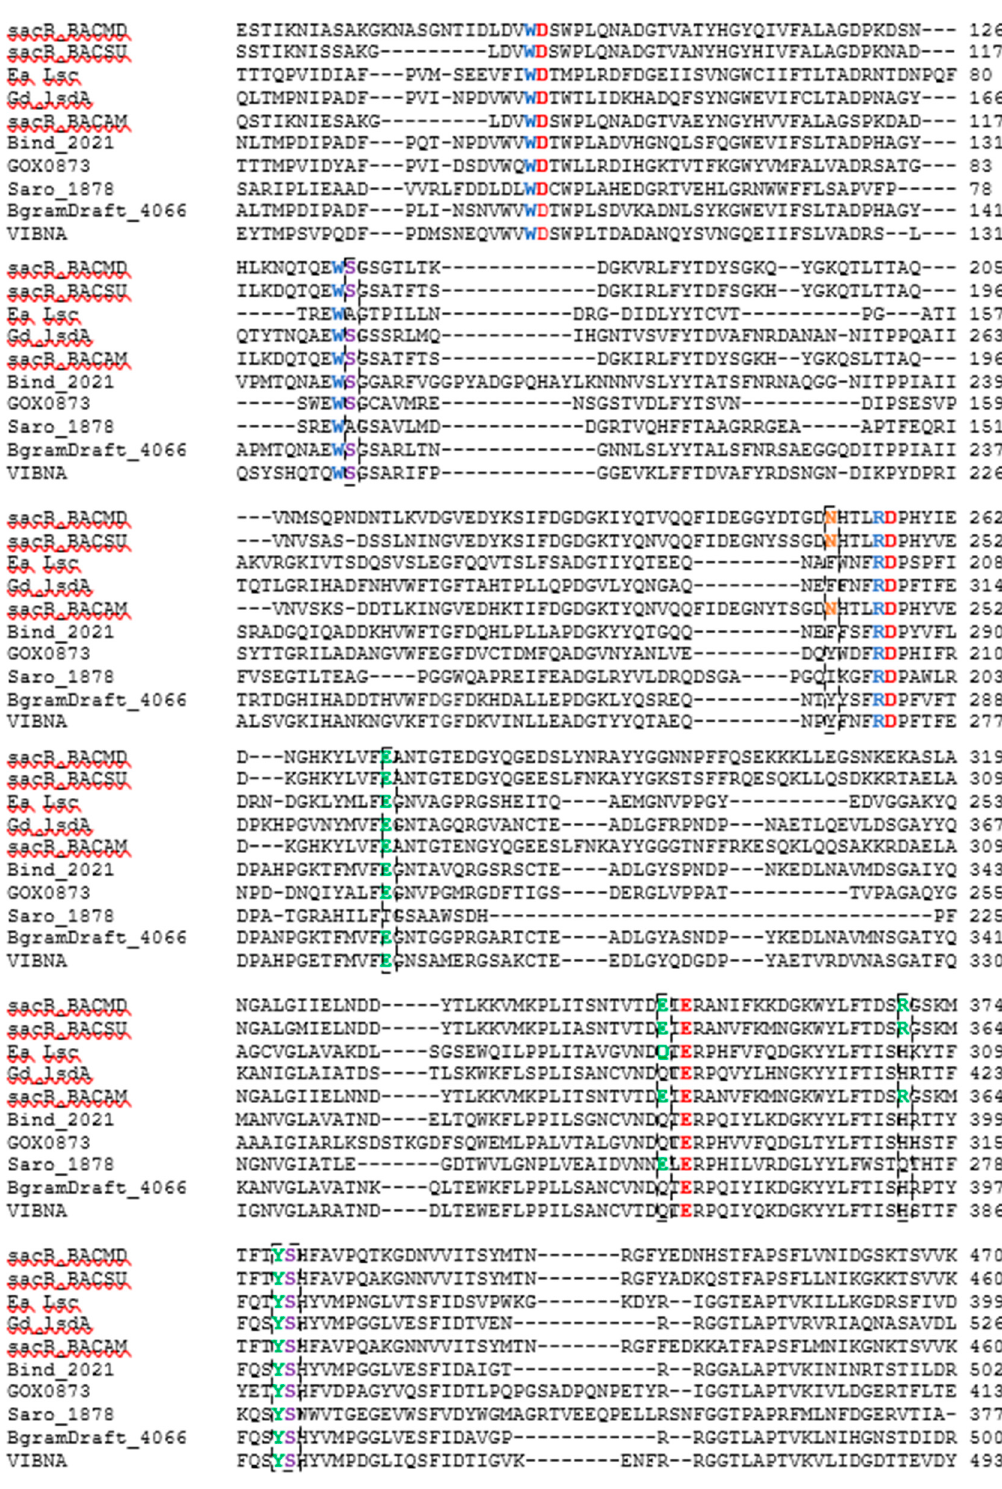
Figure 6. CLUSTAL O (1.2.4) multiple sequence alignment of LS enzymes with characterized crystal structures and enzymes investigated. The sequences for the LSs from B. megaterium (SacB_BM, D5DC07), B. subtilis (SacB_BS, P05655), E. amylovora (Ea Lsc, A0A0M3KKU6), G. diaztrophicus (Gd lsdA, Q43998), B. amyloliquefaciens (SacB_BACAM, E1UUH6), B. indica subsp. indica (Bind_2021, B2IF78), G. oxydans (GOX0873, Q5FSK0), N. aromaticivorans (Saro_1879, Q2G754), P. graminis (BgramDRAFT_4066, B1G3 × 6), and V. natriegens (VIBNA, A0A0S3EPZ1). Some residues excluded.